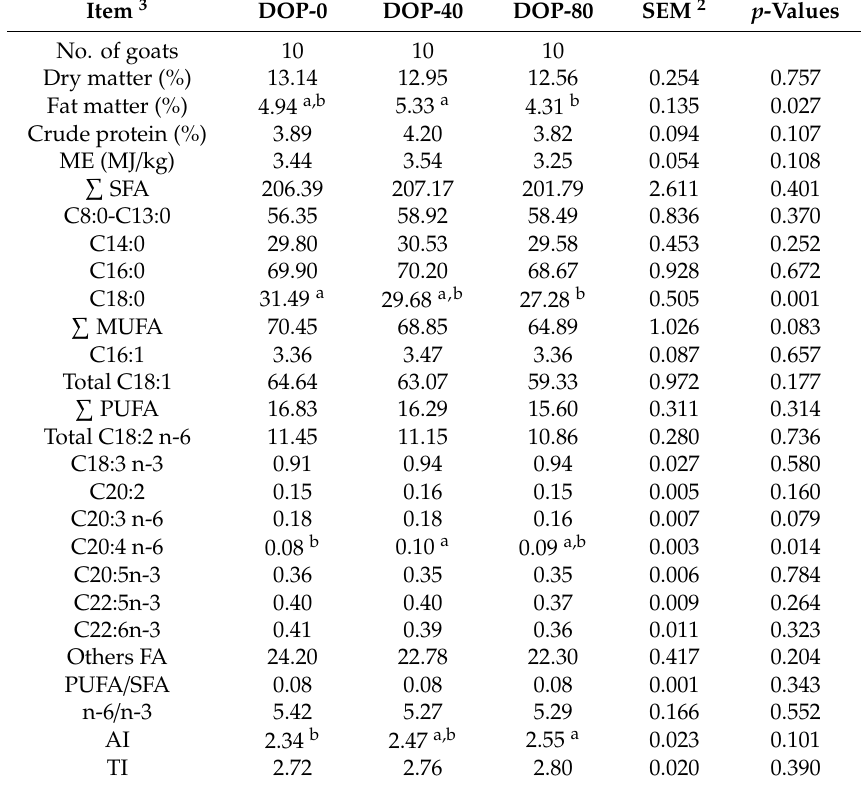
Table 2. Chemical composition and fatty acid (FA) content (expressed as mg / g dry matter) of mother’s milk (mean values of the two samples) during the natural suckling period by experimental diet type 1 . Item 3 DOP-0 DOP-40 DOP-80 SEM 2 p -Values